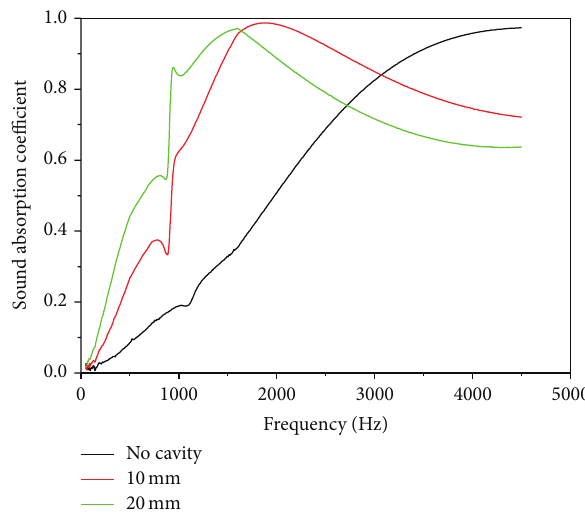
Figure 6: The sound absorption coefficient of the composites under different thickness of the